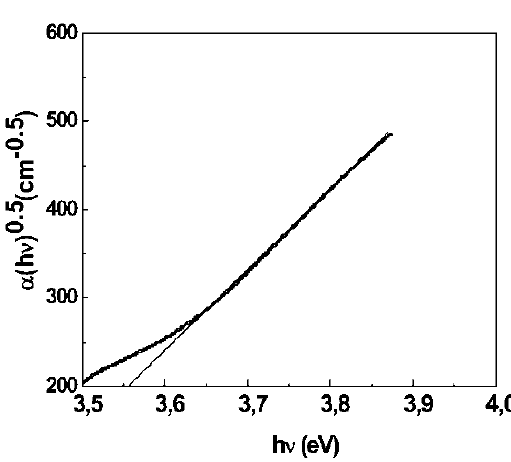
FIGURE 4d Repre´sentation des donne´es de la Figure 4c sous la forme ( a ( h n )) 0.5 ¼ f ( h n